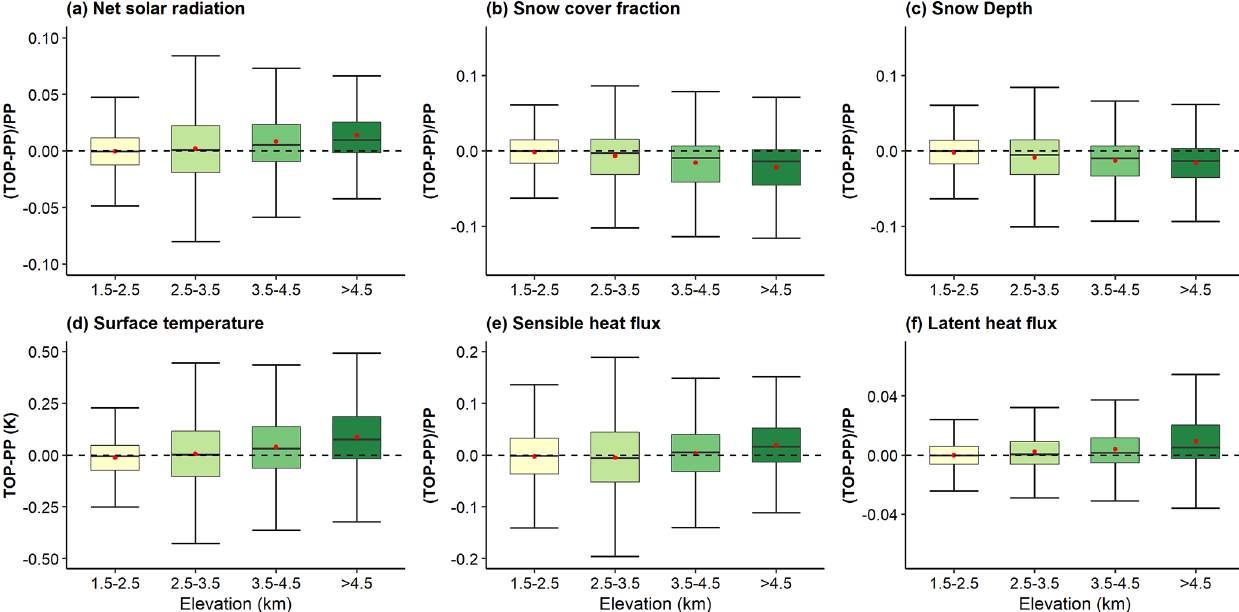
Figure 7. Boxplots of the relative (or absolute for surface temperature) differences in net solar radiation (a) , snow cover fraction (b) , snow depth (c) , surface temperature (d) , sensible heat flux (e) , and latent heat flux (f) between TOP and PP in winter at four different elevation bands. Red points represent the mean values.